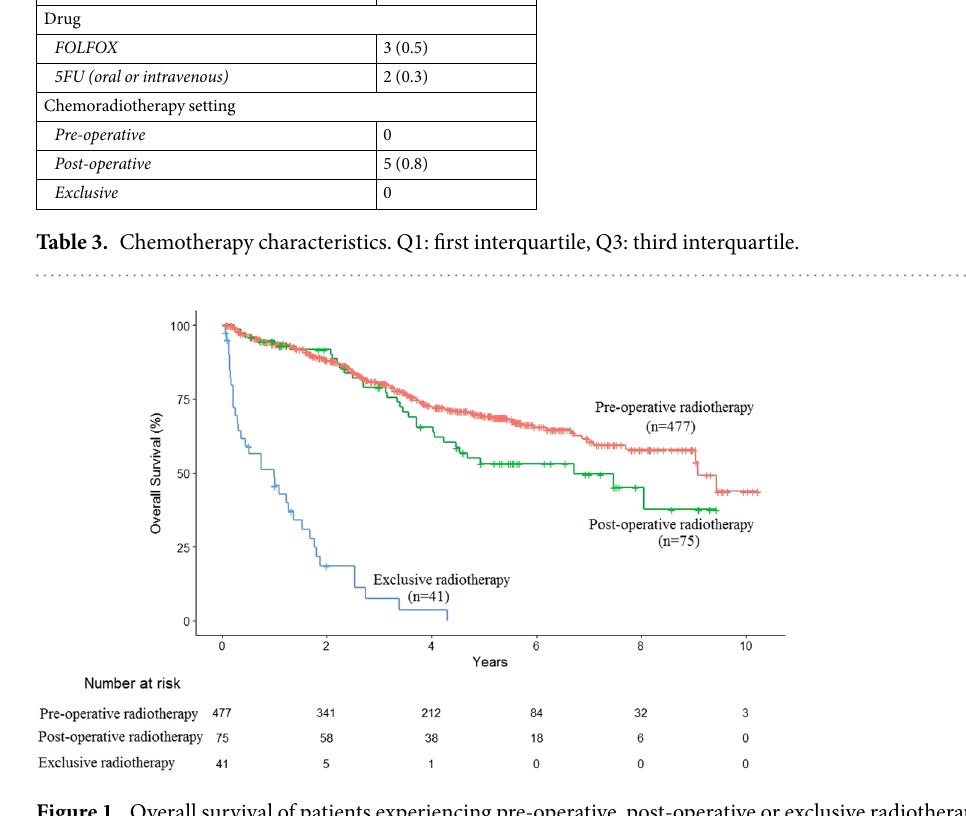
Prognostic factors of OS in the whole set of patients: univariate and multivariate analysis. As for radiotherapy characteristics, pre-operative or post-operative radiation setting was not correlated with significantly different outcome, with median OS of 9.1 years (CI95%: 9-NA) vs . 6.7 years (CI95%: 4.2-NA), p = 0.065, respectively (Fig. 1 ) . Exclusive radiotherapy was significantly associated with decreased survival with respect to pre-operative radiotherapy, with median OS of 1 year (CI95%: 0.36–1.7), p < 0.001 (Fig. 1). No rectal or pelvis radiation dose threshold was significantly correlated with OS in univariate analysis. The univariate analysis provided potential (p < 0.2) OS predictive factors, reported in Table 4. Although significant in univariate analysis, the complete tumor resection, the number of pathologically-proven involved lymph nodes, the vascular invasion and the exclu- sive radiotherapy could not be included in the multivariate analysis as they were correlated, by construction, with tumor resection. The impact of the selected factors on OS was thus studied using a Cox multivariate anal- ysis ( Table 4 ) . Regarding patients characteristics, age ( > 70 years old) was an independent risk factors of death (HR = 3.54 CI 95% (2.28–5.48), p < 0.001) and a correct nutritional condition (BMI > 18.5) was an independent protective factor of death (HR = 0.37 CI 95% (0.16–0.85), p = 0.02). Regarding tumor characteristics, stage III and poorly differentiated tumors were independent risk factors of death, with HR = 1.78 CI 95% (1.17–2.70), p = 0.007 and HR = 2.98 CI 95% (1.52–5.72), p = 0.001 respectively. Finally, tumor resection was the most impor- tant independent protective factor, with HR = 0.08 CI 95% (0.04–0.15), p < 0.001.